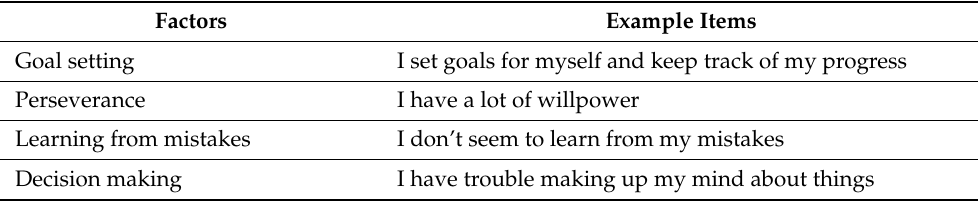
Table 3. Factors of the Spanish Short Self-Regulation Questionnaire (SSSRQ)